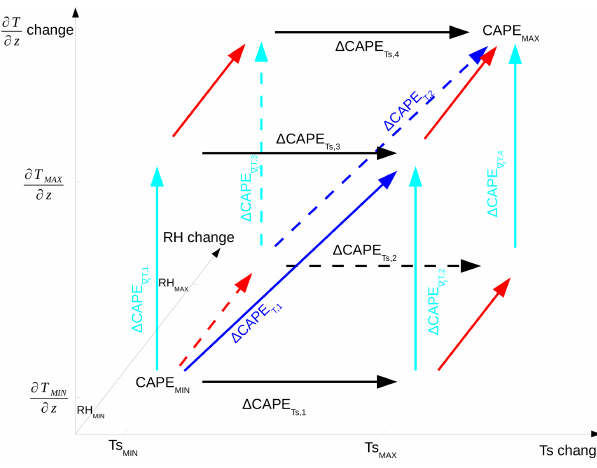
Figure 11. Schematic of the four possible CAPE differences that permit us to evaluate the contribution of the vertical gradi- ent of temperature ( (cid:49) CAPE ∇ , (cid:49) CAPE ∇ , (cid:49) CAPE ∇ , z T, 1 z T, 2 z T, 3 and (cid:49) CAPE ∇ ) and the contribution of the surface tempera- z T, 4 ture ( (cid:49) CAPE T , (cid:49) CAPE T , (cid:49) CAPE T , and (cid:49) CAPE T ) to s , 1 s , 2 s , 3 s , 4 (cid:49)